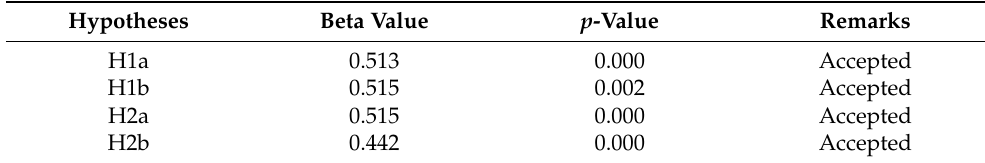
Figure 2. Framework to enhance the motivational level of academic librarians for innovative performance. Table 7. Summary of hypotheses